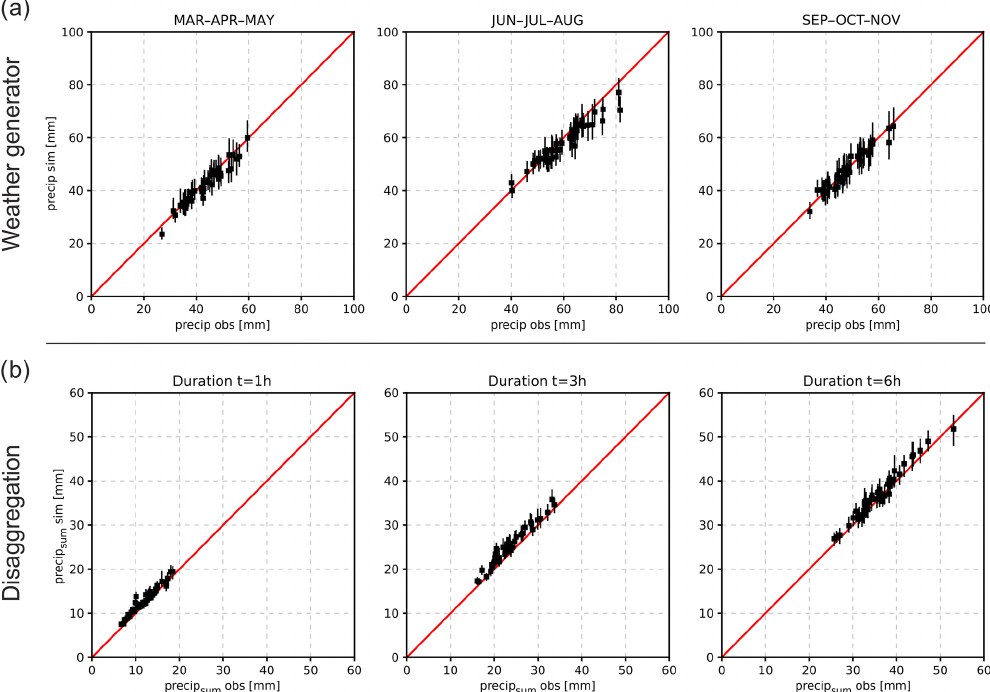
Figure 3. Validation results of the weather generator and the revised disaggregation procedure for all stations ( n = 45). The bars represent the median and the 5–95% quantile range of 100 realisations for the weather generator and disaggregation. (a) Weather generator: 99% quantile of daily precipitation for generated data compared with observed data for spring, summer and autumn. (b) Disaggregation: 99.9% quantile of 13 years of disaggregated data is compared to observed data, for the precipitation sum of 1, 3 and 6h